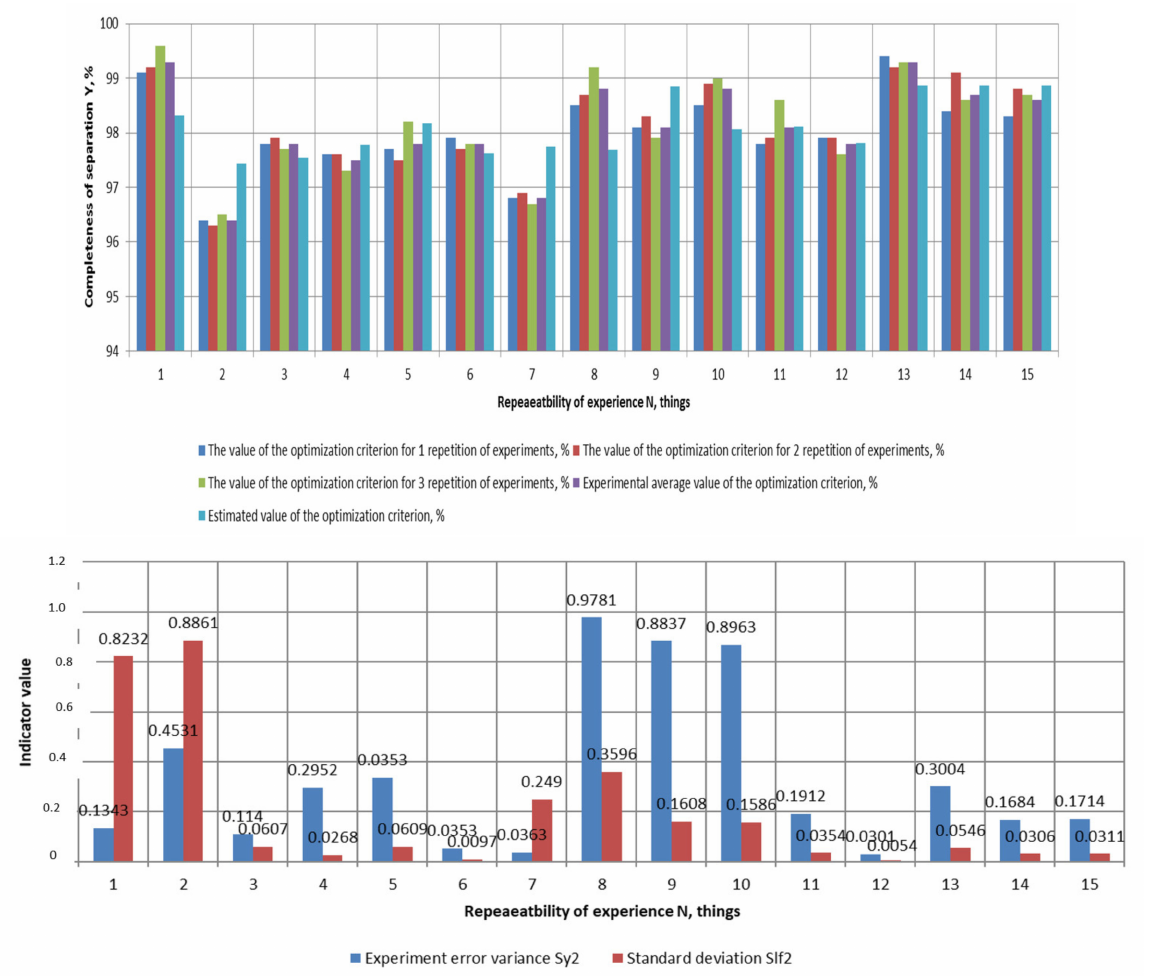
Figure 12. Statistical characteristics of experience